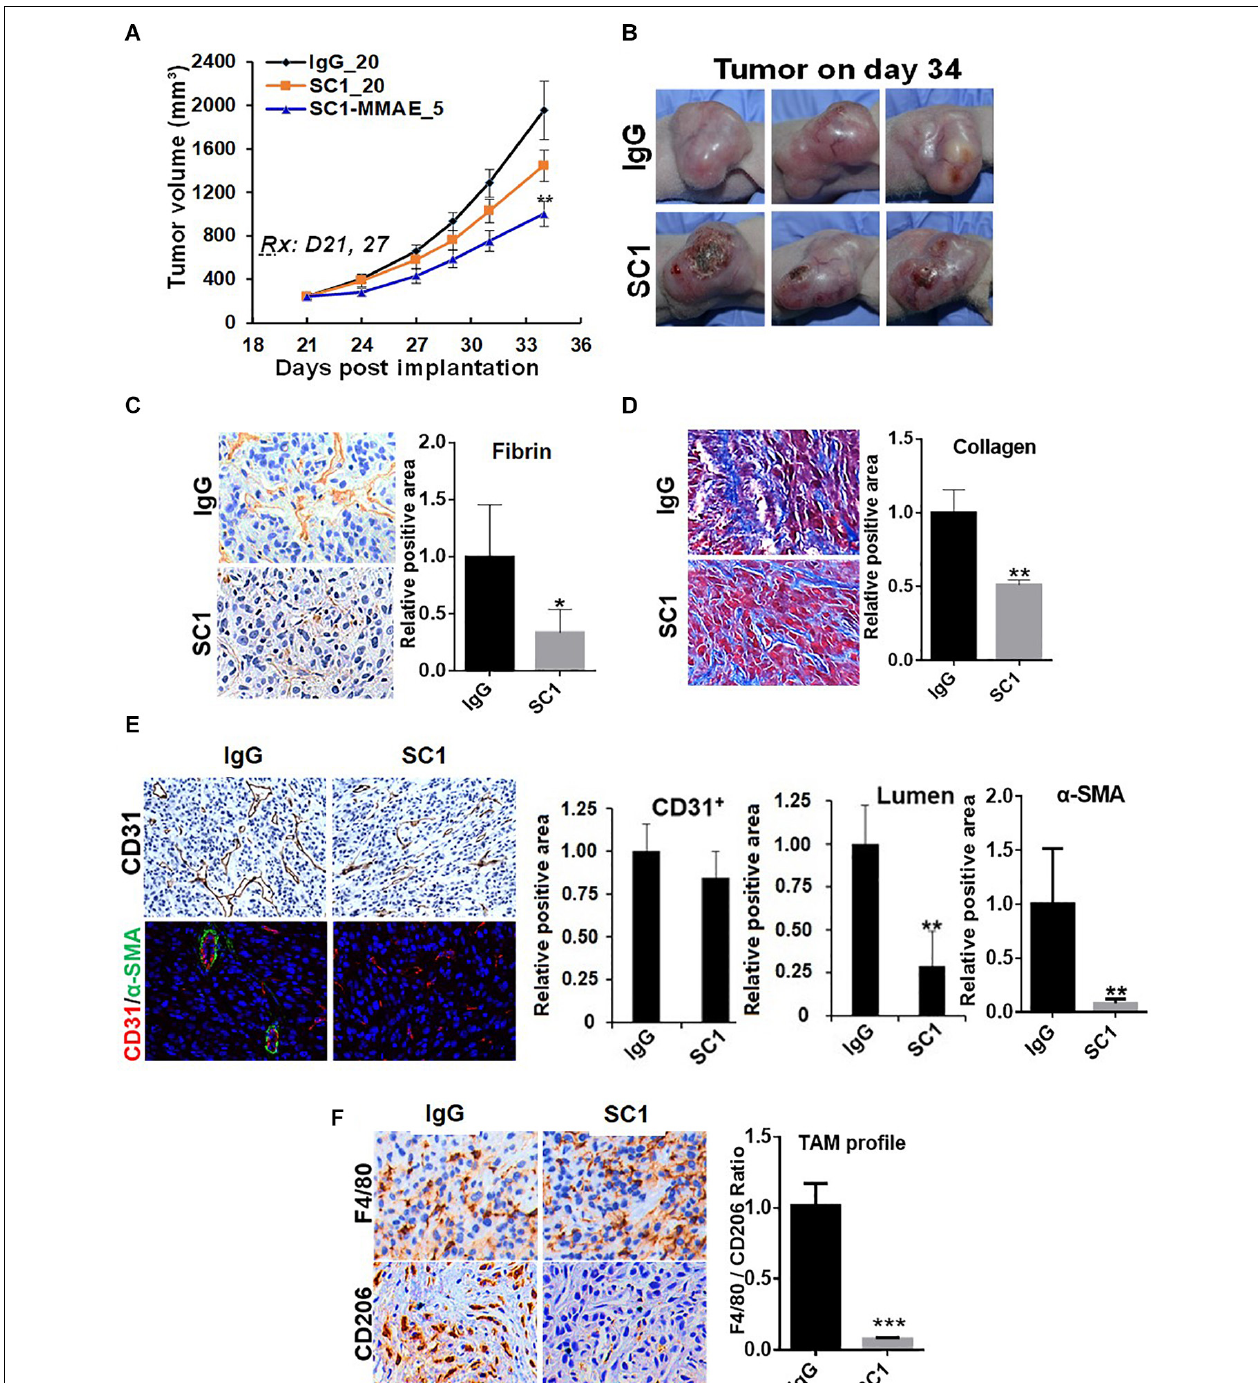
FIGURE 6 | TF-targeted antibody induces tumor microenvironment remodeling. (A) Nude mice bearing established U87MG tumors ( n = 8) were treated with 20 mg/kg IgG or SC1, 5 mg/kg SC1-MMAE i.v. 1x weekly as indicated for a total of two treatments. Tumor growth curves are plotted. (B) Significant necrosis was observed in SC1-treated tumors. Tumor images are shown. (C,D) Fibrin deposits served as TF activity biomarker (C) and collagen distribution (D) were stained by IHC as described in section “Materials and Methods.” (E) Tumor blood vessels were analyzed by IHC with anti-CD31 or IF co-staining with anti-CD31 and anti- α -SMA. CD31-positive/lumen area and α -SMA-positive area in CD31 + vessels were quantified. (F) TAM infiltration was tested by IHC staining with anti-F4/80 and anti-CD206 similarly as Figure 5 . The calculated the ratio of CD206 versus F4/80 indicates the levels of M2-type TAMs. For (C–F) , representative images are shown (left panels) and quantified (right panels). * P < 0.05, ** P < 0.01, *** P < 0.001.